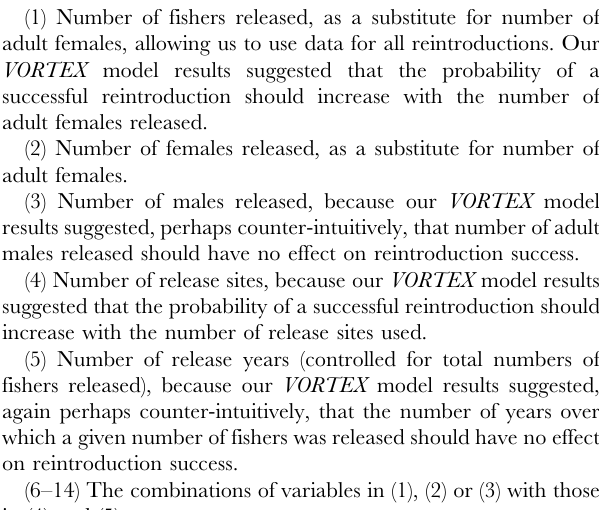
Table 3. Predicted effects of removing fishers for 3, 5, or